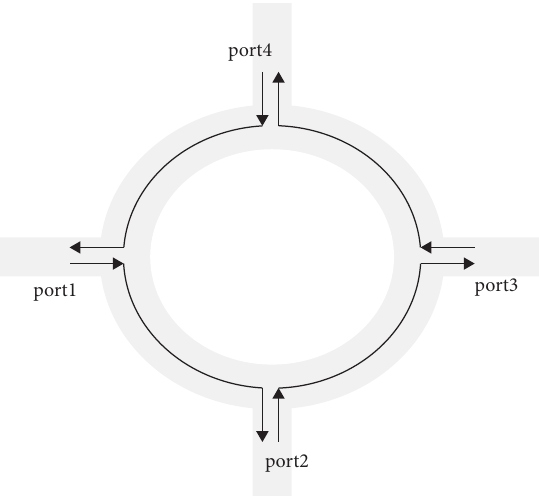
Figure 1: Power is propagated by right-handed circulation and transmitted through ports 1 to 2, 2 to 3, 3 to 4, and 4 to 1.